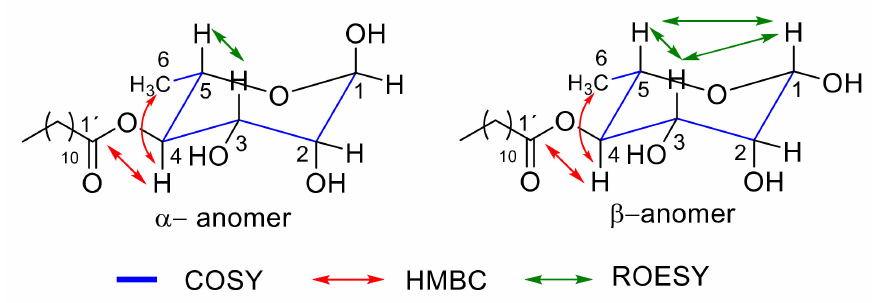
Figure 2. Most representative signals of 2D RMN (COSY, HMBC and ROESY) spectra of 1e